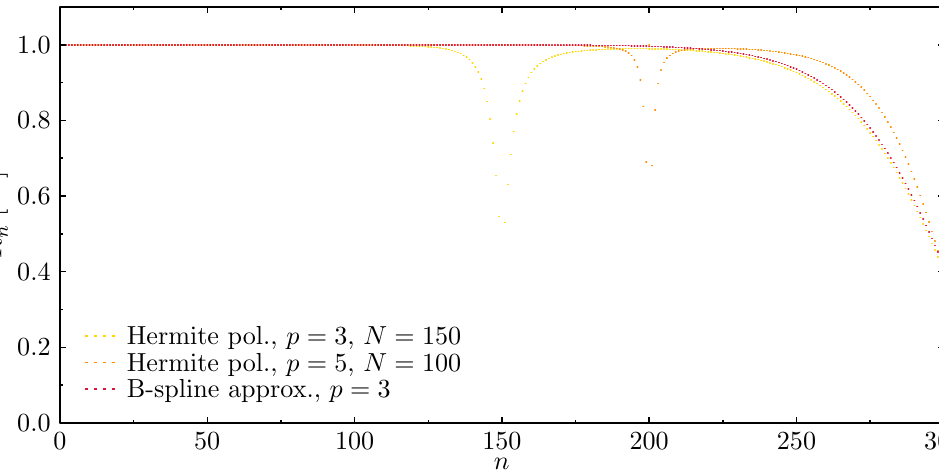
Figure 12. Fitness of natural vibration modes of the beam calculated based on different approximation polynomials, in the case of a beam with simply-supported